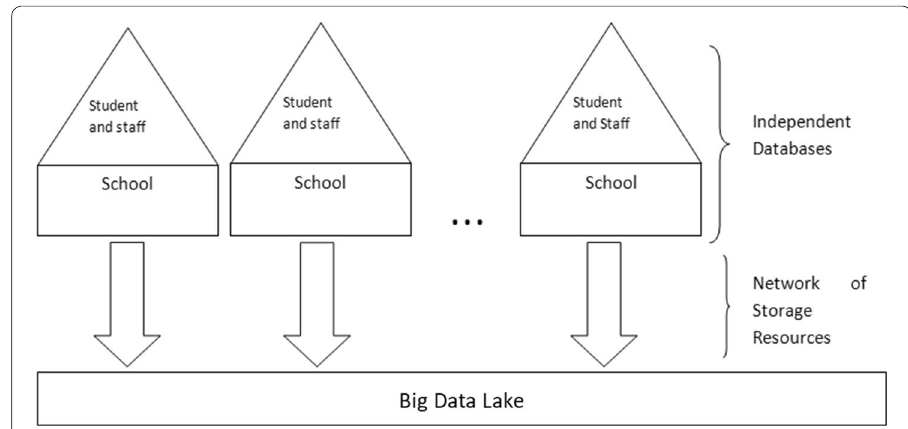
Fig. 6 Data Warehouse Model of Multiple Schools